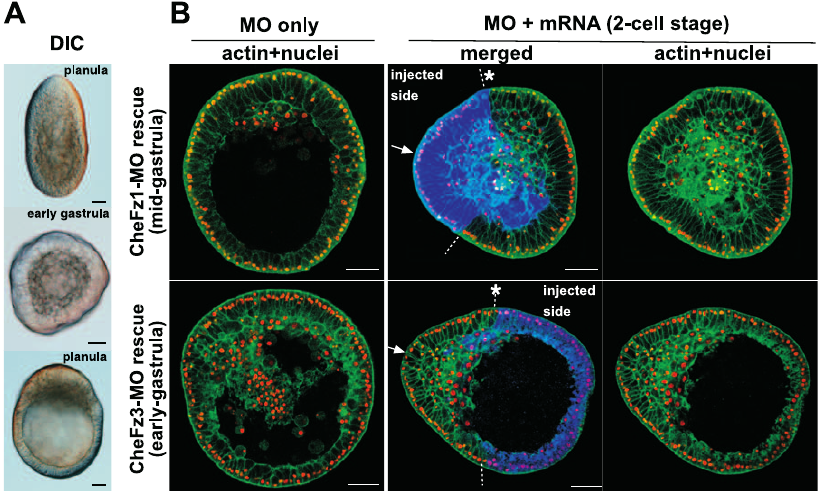
Figure 7. Embryo Polarity Redirected by Ectopic CheFz1 or CheFz3 (A) Differential interference contrast images of embryos following injection of 0.5 mg/ml RNA coding for CheFz1 or CheFz3 into eggs before fertilisation compared to uninjected controls. Stages as indicated. (B) Confocal images of early gastrula embryos stained with phalloidin/ToPro3 following morpholino injection into the egg (left column) and with polarity restored by injection of 0.5 mg/ml RNA (lacking the morpholino target site) into one blastomere at the two-cell stage (right two columns). Top row: CheFz1 misexpression; Bottom row: CheFz3 misexpression. Blue indicates the progeny of the RNA-injected cell revealed by fluorescent dextran. Arrows indicate ectopic pointed oral poles. The original position of the egg animal pole is deduced to lie on the injected–uninjected boundary (asterisk) since the first cleavage passes through the animal pole, and can be further pinpointed by residual endogenous polarity in CheFz1-injected embryos. Bars ¼ 40 l m.